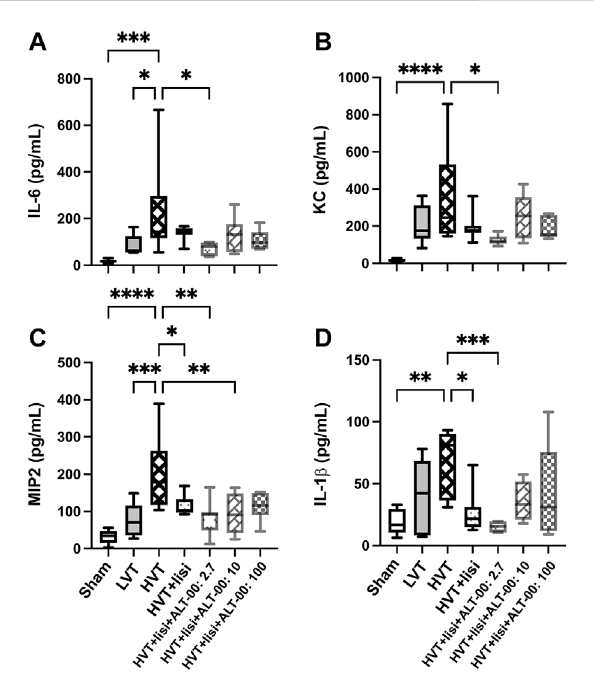
FIGURE 4 Assessment of in fl ammatoryactivation. (A) Interleukin (IL)-6levelsin bronchoalveolar lavage fl uid (BALF) were signi fi cantly elevated in the high tidal volume (HVT) group versus the sham and the low tidal volume (LVT) group. Treatment with lisinopril (lisi) + ALT-00 (2.7 μ g/kg/min) decreased IL-6 levels versus the HVT group. (B) The concentration of keratinocyte-derivedcytokine(KC)intheHVTgroupwasincreasedversus sham. Treatment with lisi +ALT-00 (2.7 μ g/kg/min) decreased KC levels versustheHVTgroup. (C) Themacrophagein fl ammatoryprotein-2(MIP2) levelsintheHVTgroupwerehighlyincreasedversustheshamandtheLVT group. Treatment with lisi ± ALT-00 (2.7 and 10 μ g/kg/min) reduced MIP2 versus the HVT group. (D) The IL-1 β levels in the HVT group were increased versus the sham group. Treatment with lisi ± ALT-00 (2.7 μ g/kg/min) decreased IL-1 β levels versus the untreated